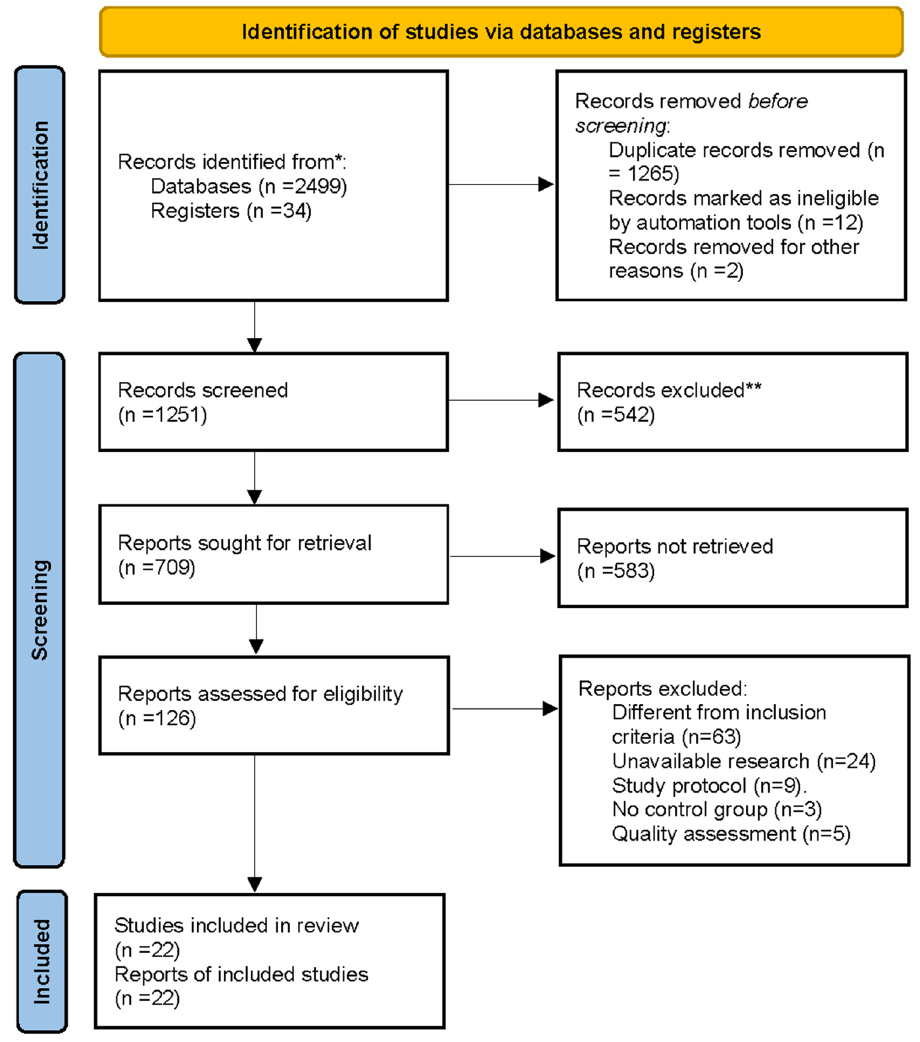
Figure 1. PRISMA Flow diagram of search strategy and included studies.